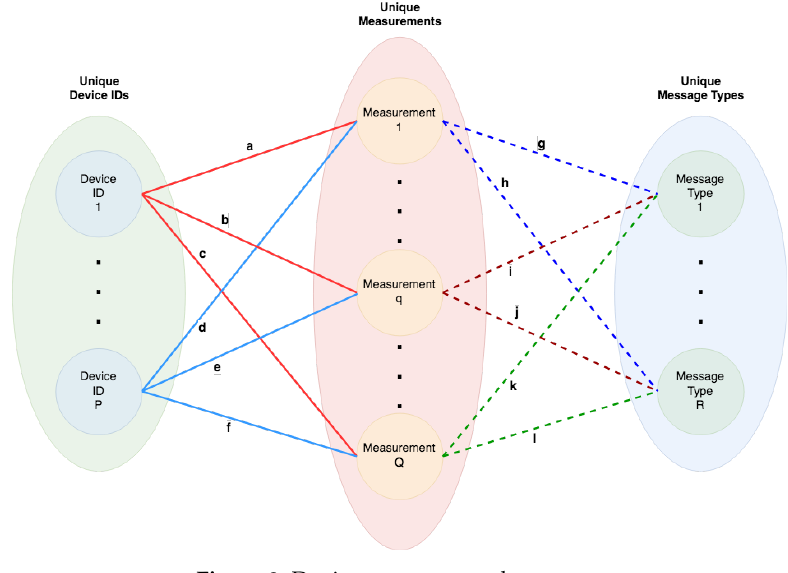
Figure 8. Device message graph